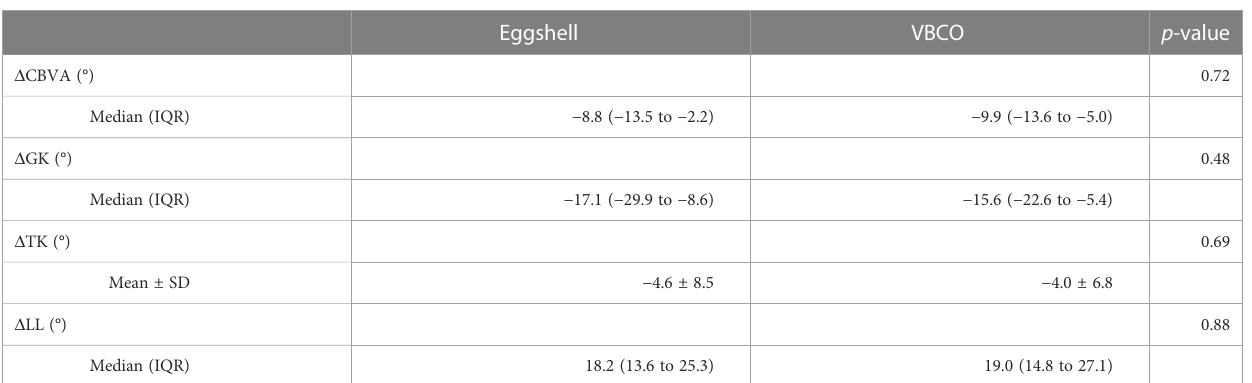
TABLE 6 Comparison of sagittal parameter correction after follow-up.